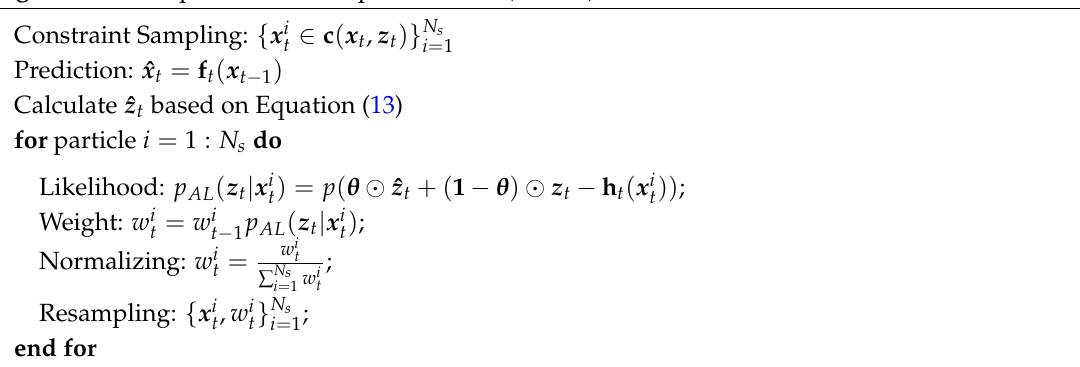
Algorithm 3 Adaptive constraint particle filter